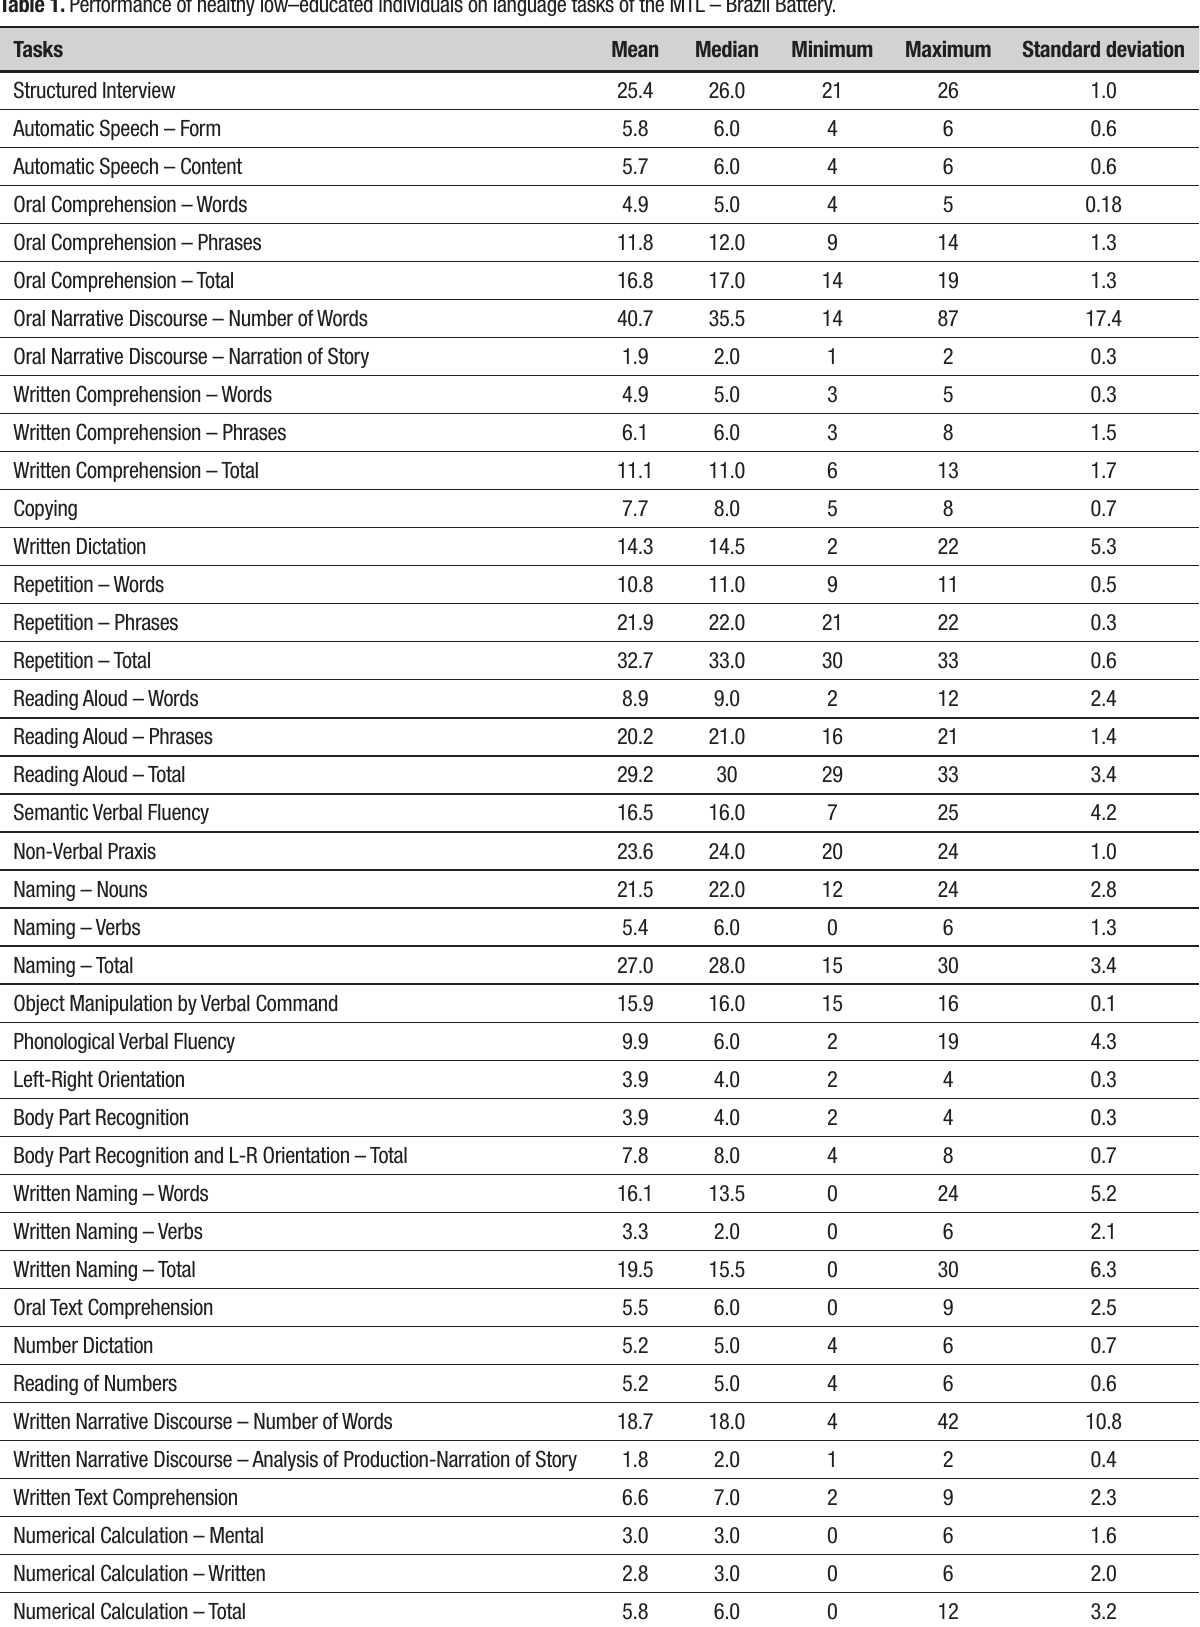
Table 1. Performance of healthy low–educated individuals on language tasks of the MTL – Brazil